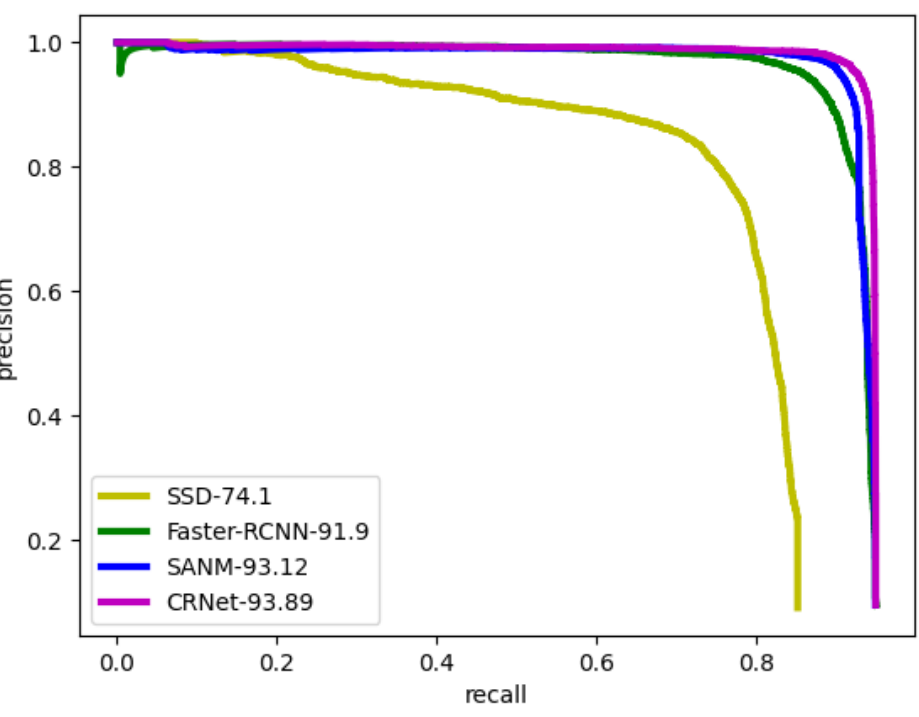
Figure 7. The PR curves of our model and other methods at IoU 0.5 on the Brainwash dataset.